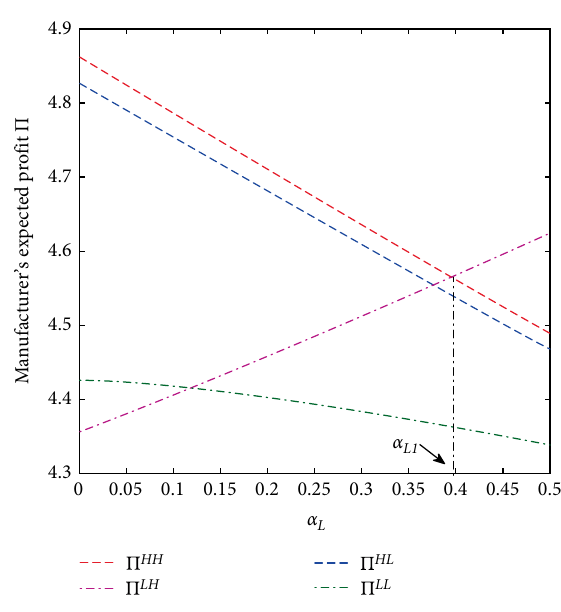
Figure 6: Relationship 𝛼